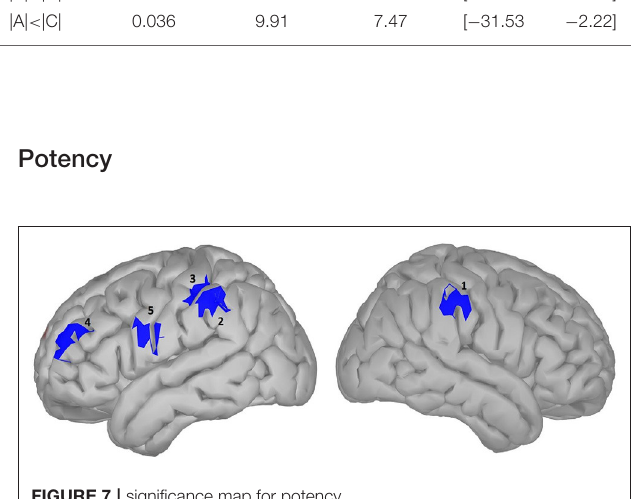
FIGURE 7 | significance map for potency.